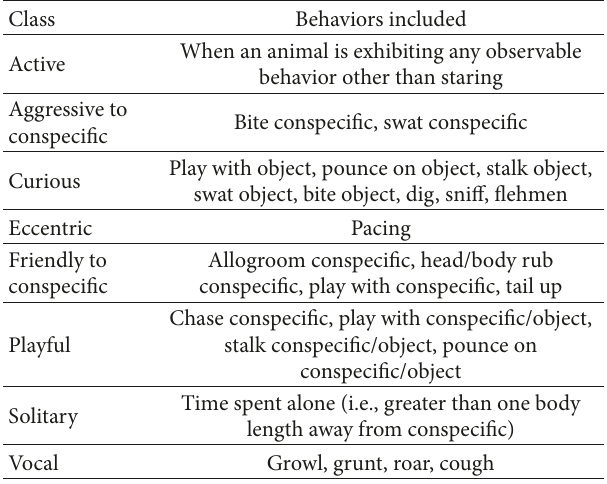
Table 3: Personality trait classes consisting of behaviors from full ethogram, included in Table